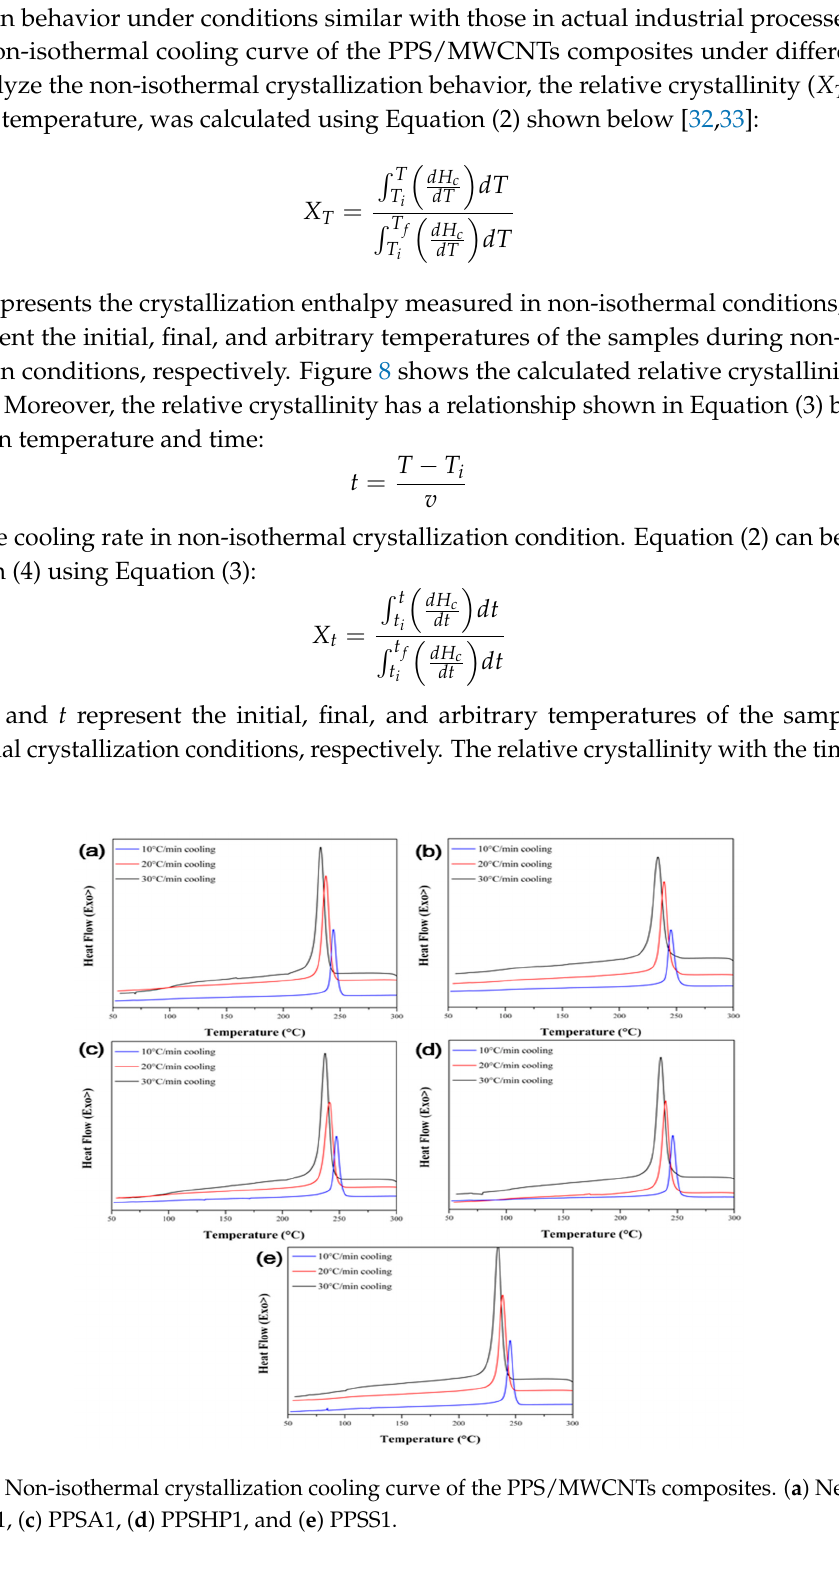
Figure 8. Plots of relative crystallinity versus temperature of the PPS/MWCNTs composites at different cooling rates. ( a ) Neat PPS, ( b ) PPSP1, ( c ) PPSA1, ( d ) PPSHP1, and ( e ) PPSS1.